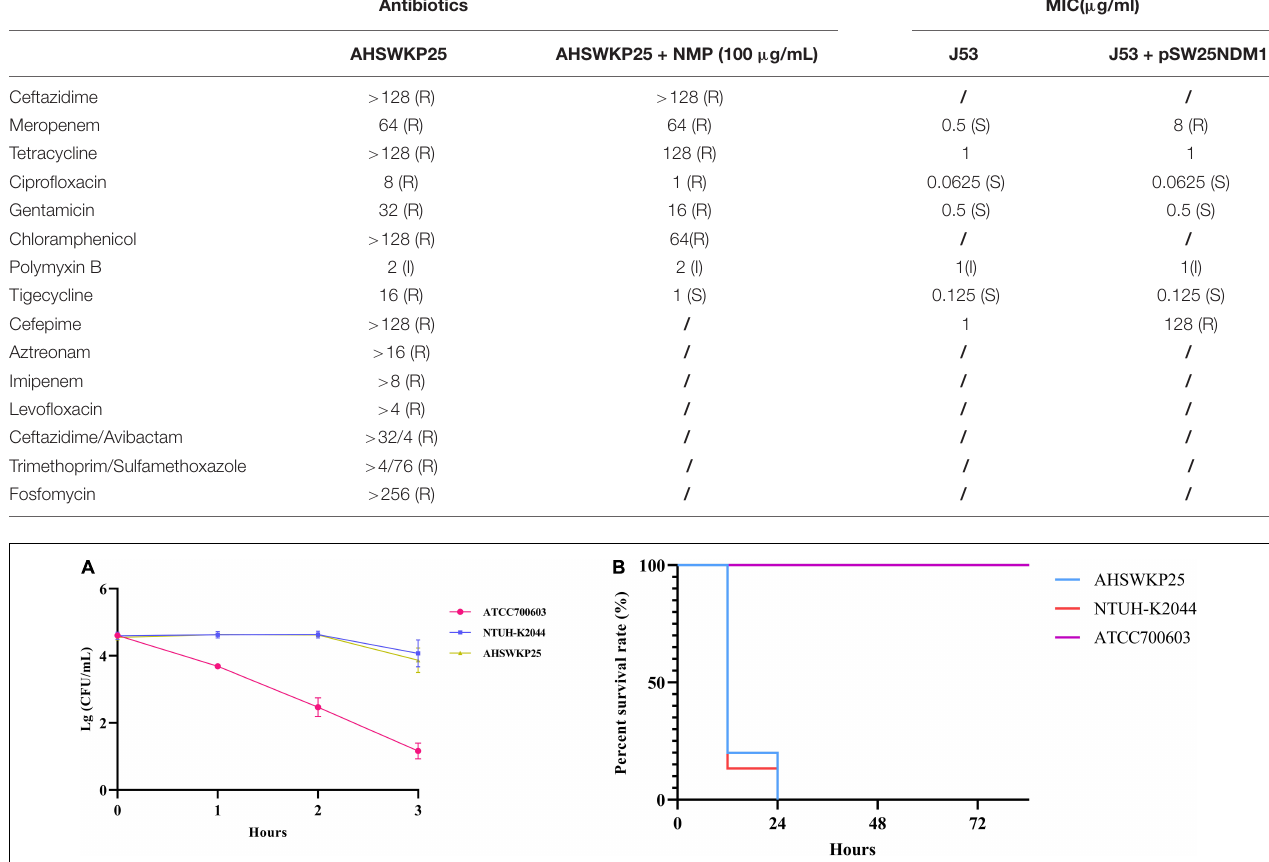
FIGURE 1 | Serum resistance and pathogenicity of AHSWKP25. (A) The survival rate of AHSWKP25, ATCC700603, and NTUH-K2044 in healthy human serum over 3 h. The data are expressed as the mean ± SEM (standard error of the mean). (B) The survival rate of G. mellonella larvae (15 biological replicates) inoculated with AHSWKP25, NTUH-K2044, and ATCC700603, respectively. The experiments were repeated in triplicate